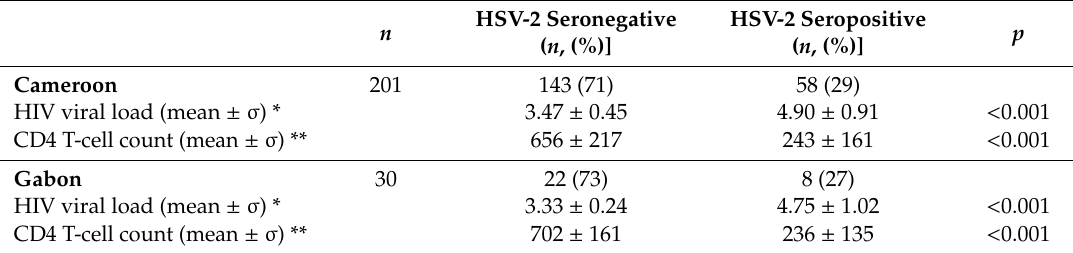
Table 2. HSV-2 seropositivity, HIV-1 viral load, and CD4 T-cell count in 302 individuals under first-line therapy with virological failure in Central Africa (Cameroon, Central African Republic, Chad, and